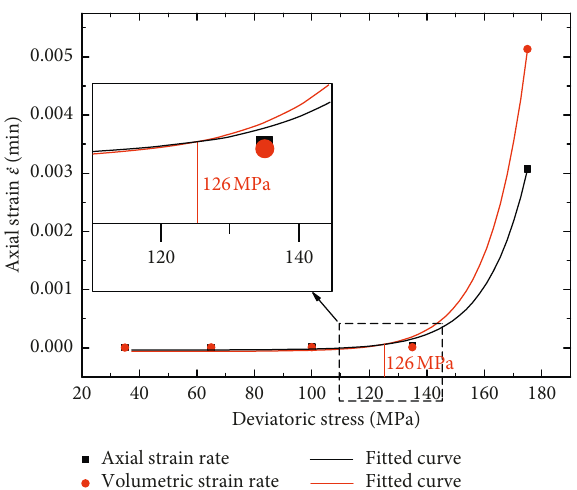
Figure 7: Relationship between axial strain rate and deviatoric stress ( σ 3 � 3MPa, T � 600 ° C).